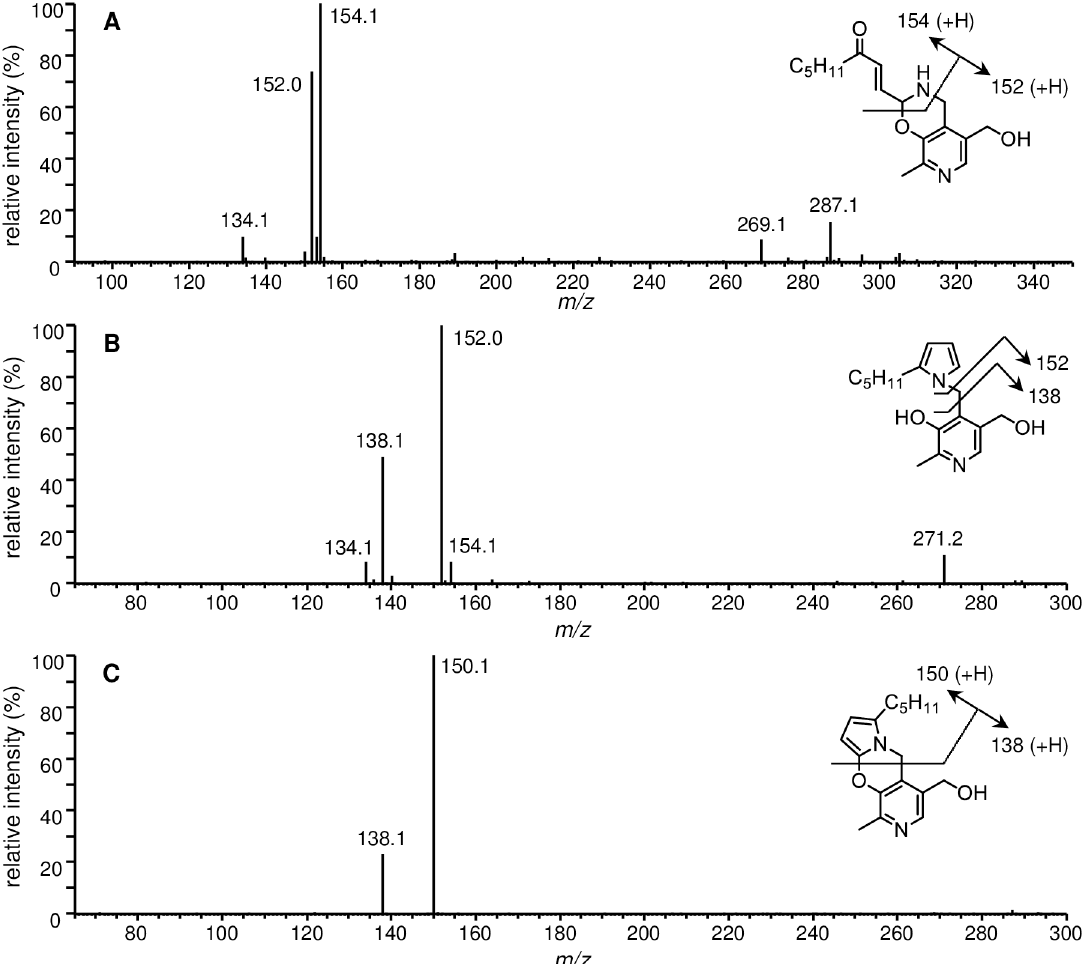
Fig 2. LC/ESI-MS/MS analysis of PM-ONE adducts (A) PO1 ( m/z 305.1), (B) PO7 ( m/z 289.1) and (C) PO8 ( m/z 286.9).